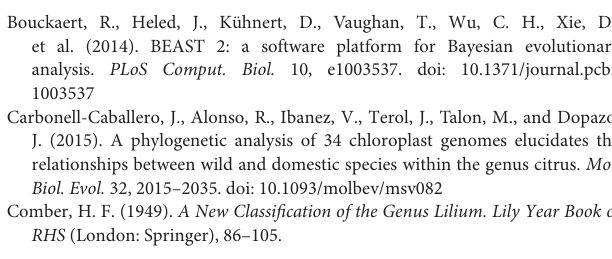
Supplementary Figure S1 | Phylogenetic tree constructed from the plastome sequences (LSC + IR + SSC) of 70 Lilium taxa and two outgroup taxa using the maximum parsimony method. The outer circle represents the classification of the genus Lilium . The phylogenetic tree is shown in the inner layer. Numbers associated with the branches are bootstrap values. A and B indicate the two major groups distinguished based on all three phylogenetic reconstruction methods. Clades I, II, III, IV, V, VI, VII, and VIII indicate the major clades of Lilium species. Terminal names comprise species. Species that conform to Comber’s classification are shown in black color and those showing inconsistent placements are shown in red color. Species abbreviation in sections: Ps, Pseudolirium ; Le, Leucolirion ; Ar, Archelirion ; Li, Lilium ; Si, Sinomartagon ; Ma, Martagon ; Da, Dautolirion ; and No, Nomocharis -like Lilium . Supplementary Figure S2 | Phylogenetic tree constructed from the plastome sequences (LSC + IR + SSC) of 70 Lilium taxa and two outgroup taxa using the Bayesian inference method. The outer circle represents the classification of the genus Lilium . The phylogenetic tree is shown in the inner layer. Numbers associated with the branches are bootstrap values. A and B indicate the two major groups distinguished based on all three phylogenetic reconstruction methods. Clades I, II, III, IV, V, VI, VII, and VIII indicate the major clades of Lilium species. Terminal names comprise species. Species that conform to Comber’s classification are shown in black color and those showing inconsistent placements are shown in red color. Species abbreviation in sections: Ps, Pseudolirium ; Le, Leucolirion ; Ar, Archelirion ; Li, Lilium ; Si, Sinomartagon ; Ma, Martagon ; Da, Dautolirion ; and No, Nomocharis -like Lilium . Supplementary Table 1 | The sample information including classification, distribution details, vouchers, sampling, and data source. Supplementary Table 2 | Sequencing data information and assembly statistics of plastomes. Supplementary Table 3 | Gene composition of the plastomes in Lilium . Supplementary Table 4 | Mutations in different regions of plastomes in Lilium . Supplementary Table 5 | Variant analysis among clades in Lilium